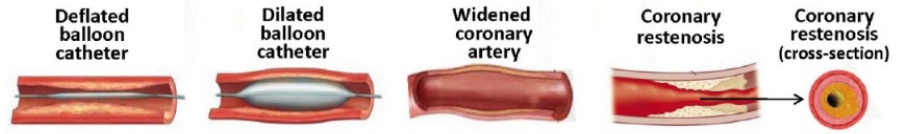
Figure 1. Coronary restenosis after coronary angioplasty with the balloon, Reproduced with permission from [3] .